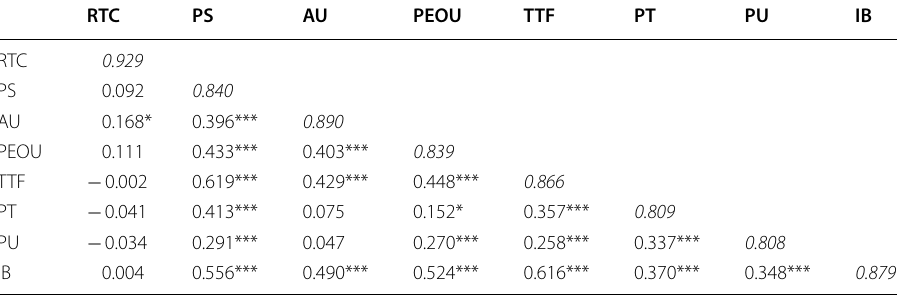
Inclined italic lines represent the square root of the AVE of each variable Significance of correlations: *p < 0.050, **p < 0.010, ***p <